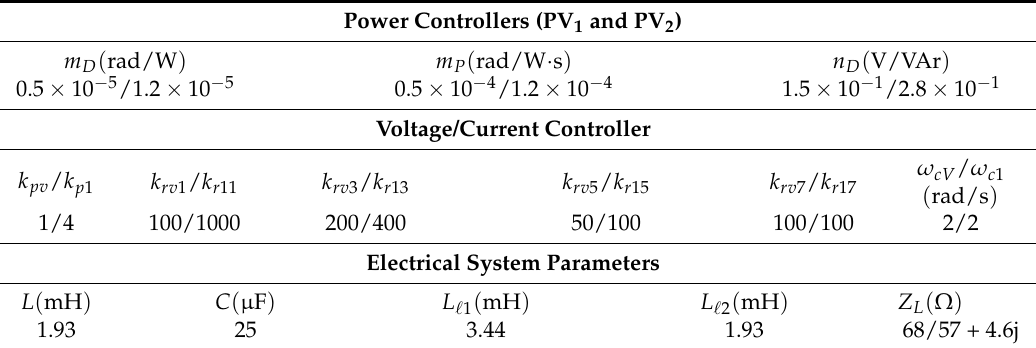
Table 2. Photovoltaic-grid-connected inverters (PV-GCI) control parameters.